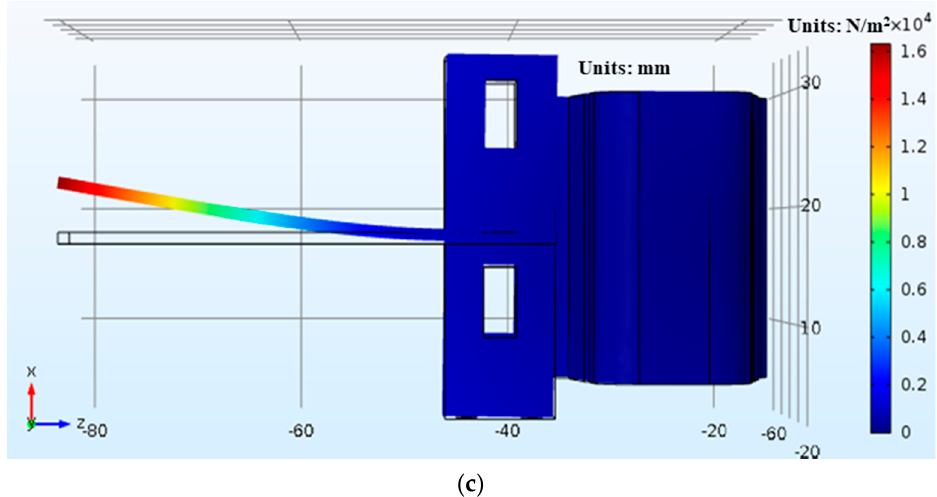
Figure 5. Modality of the actuator at different frequencies. ( a ) The vibration form of actuator when f = 245.42 Hz. ( b ) The vibration form of actuator when f = 511.49 Hz. ( c ) The vibration form of actuator when f = 603.3 Hz.